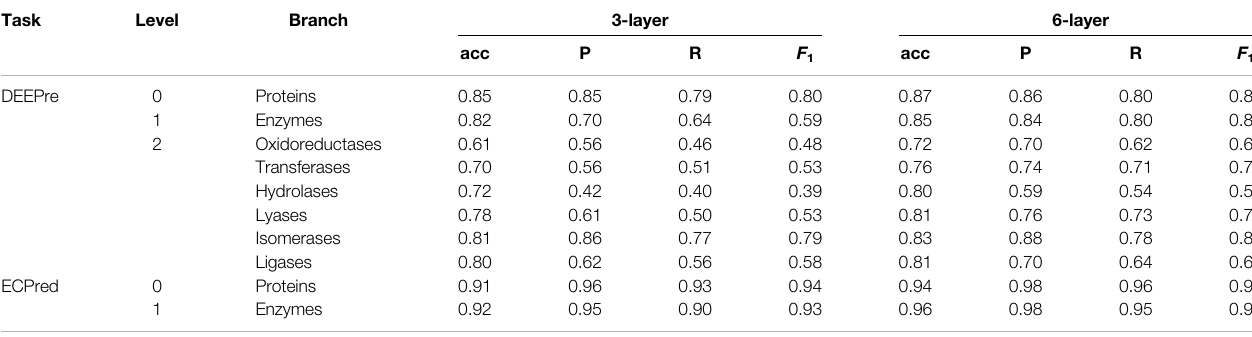
TABLE 5 | Detailed performance indexes of DAttProt. Task